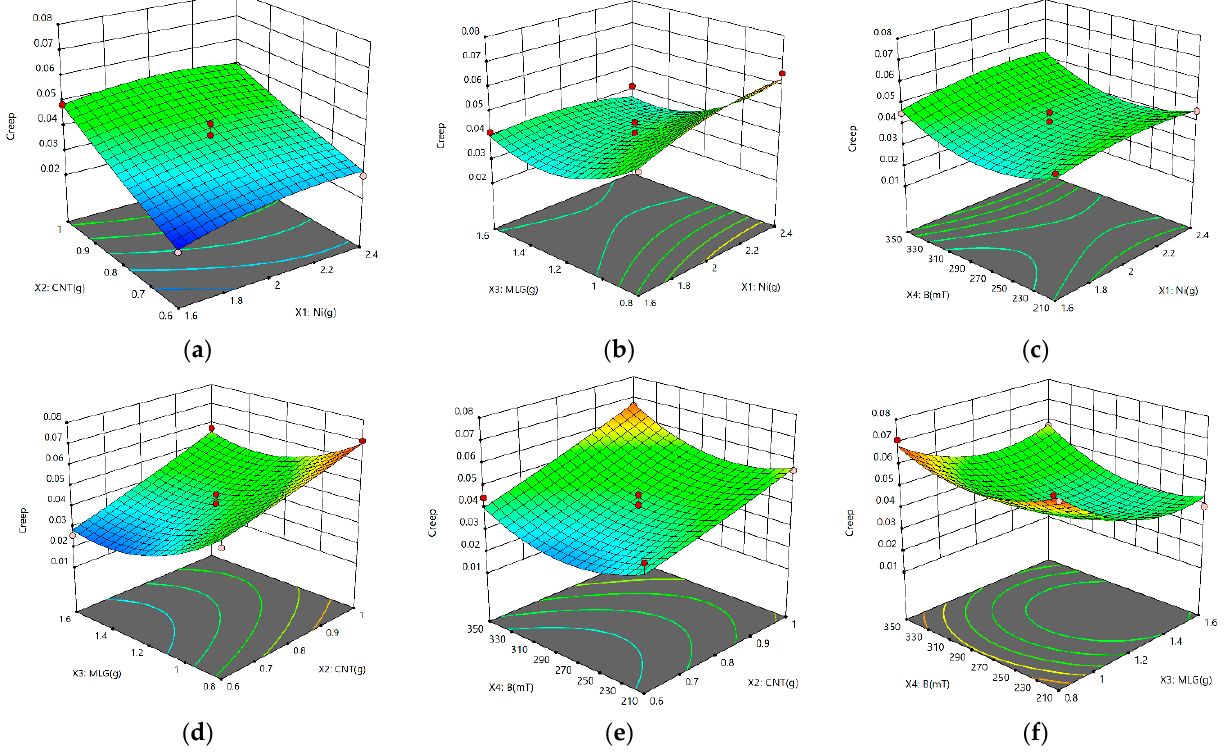
Figure 10. 3D response surface plots. ( a ) Interaction between the MWCNT and Ni content; ( b ) interaction between the MLG and Ni content; ( c ) interaction between B and Ni content; ( d ) interaction between MLG and MWCNT content; ( e ) interaction between MWCNT content and B; ( f ) interaction between MLG content and B.